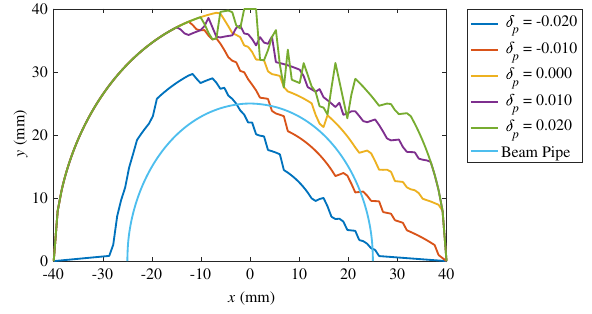
FIG. 6. Dynamic aperture for the norminal lattice.